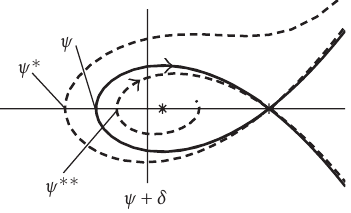
Figure 3.4. Separatrices related to the saddle point (1,0) for a = 0 (solid lines) and a > 0 (dashed